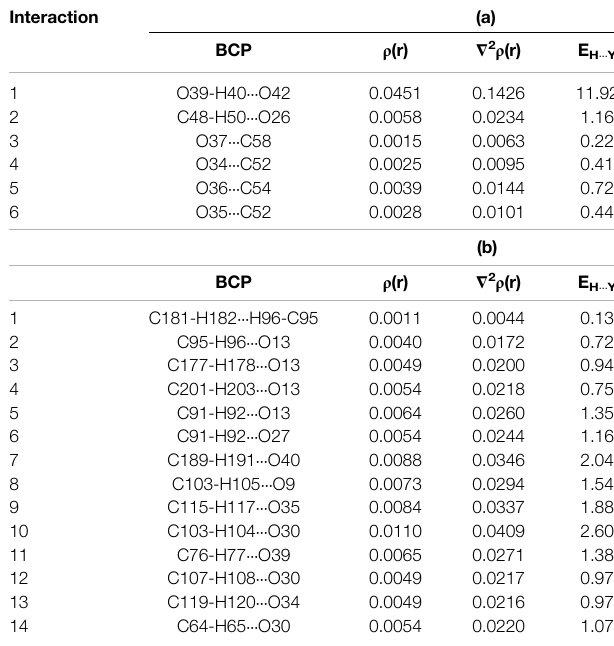
TABLE 3 | Topological parameters (in a.u.) and interaction energies E H / Y (in kcal mol-1) of (a) the representation of Compound 1 forming hydrogen bonds connectingbothspeciesofV(V),and(b)theformulaunitshowingthediprotonated decavanadate and four dioxidovanadium(V)-tpma moieties.